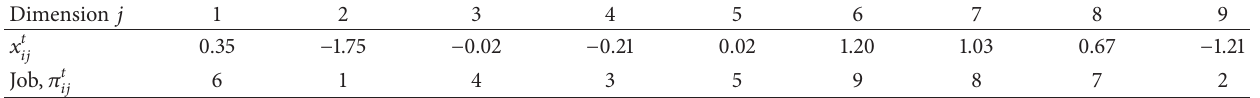
Table 1: Solution representation and the corresponding job permutation using SPV rule.